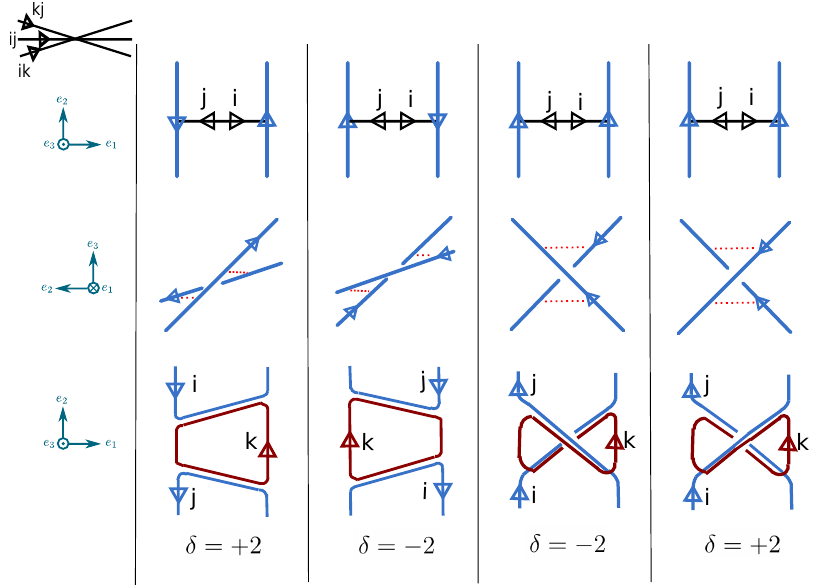
Figure 18 . The extra correction factors q δ contributing to the exchange weights. The format here is similar to figure 17. In the first row we show the standard projection onto C . The ij -leaf space projections are shown in the second row, where we use dotted red lines to indicate locations of the ik - and kj -exchanges near the ij -exchange. In the third row we show the standard projection of the extra lift containing a small loop (in red) on sheet k